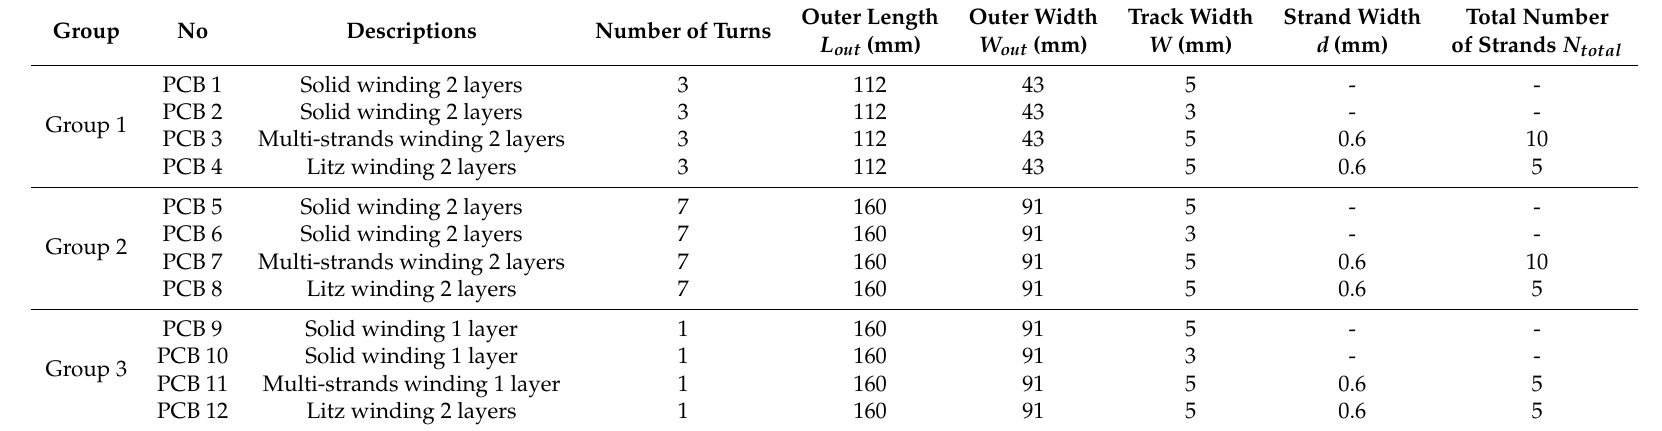
Table 3. Two ounces two-layer winding